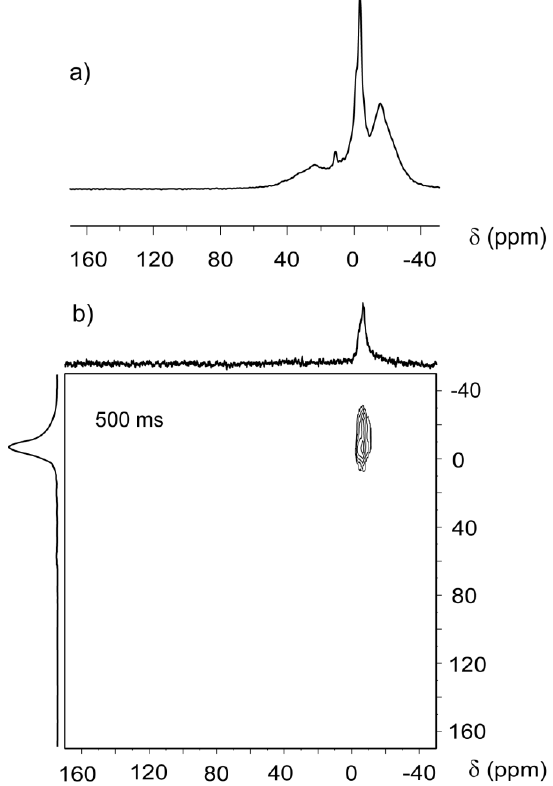
Figure 3. ( a ) CF-HP 129 Xe spectrum of Beola Monte Rosa; ( b ) two-dimensional continuous flow hyperpolarized (2D EXSY) spectrum acquired with 500 ms exchange time and 1 s recycle delay. F1 and F2 projections are also depicted.